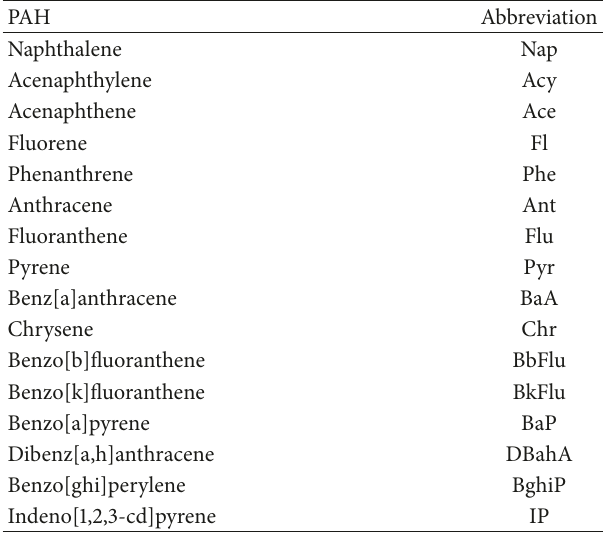
Table 1: The full names and abbreviations of EPA 16 PAHs related to this